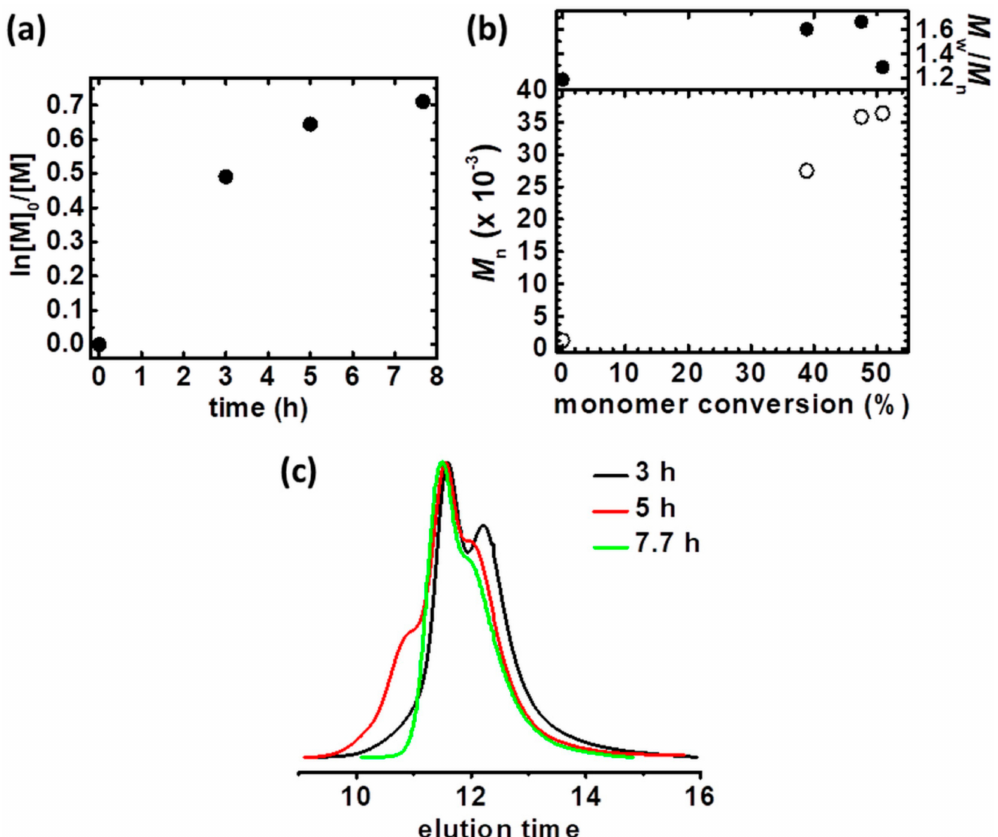
Figure 2. ( a ) First-order kinetic plot of monomer conversion vs. polymerization time for constant potential electrolysis in the preparation of Rif-(P n BA-Br) 3 macromolecules, ( b ) M n and M w / M n vs. monomer conversion and ( c ) GPC traces of n BA polymerization and their evolution over reaction time. Table 1, entry